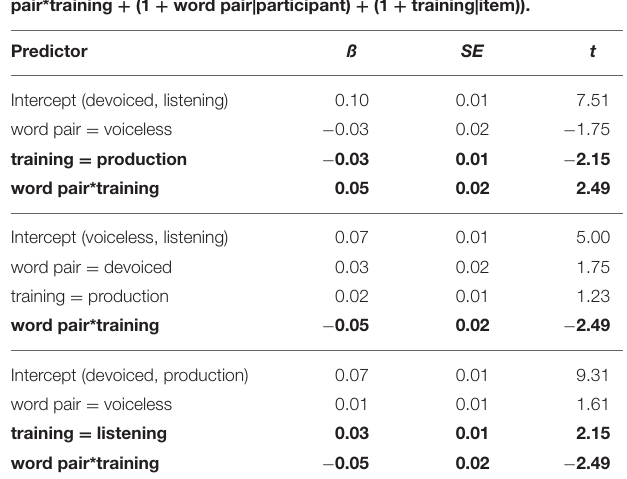
FIGURE 4 | Acoustic differences of relative burst intensity for devoiced ( * Palken ) vs. voiceless ( Palme ) word pairs and listening vs. production training. Whiskers represent standard errors.